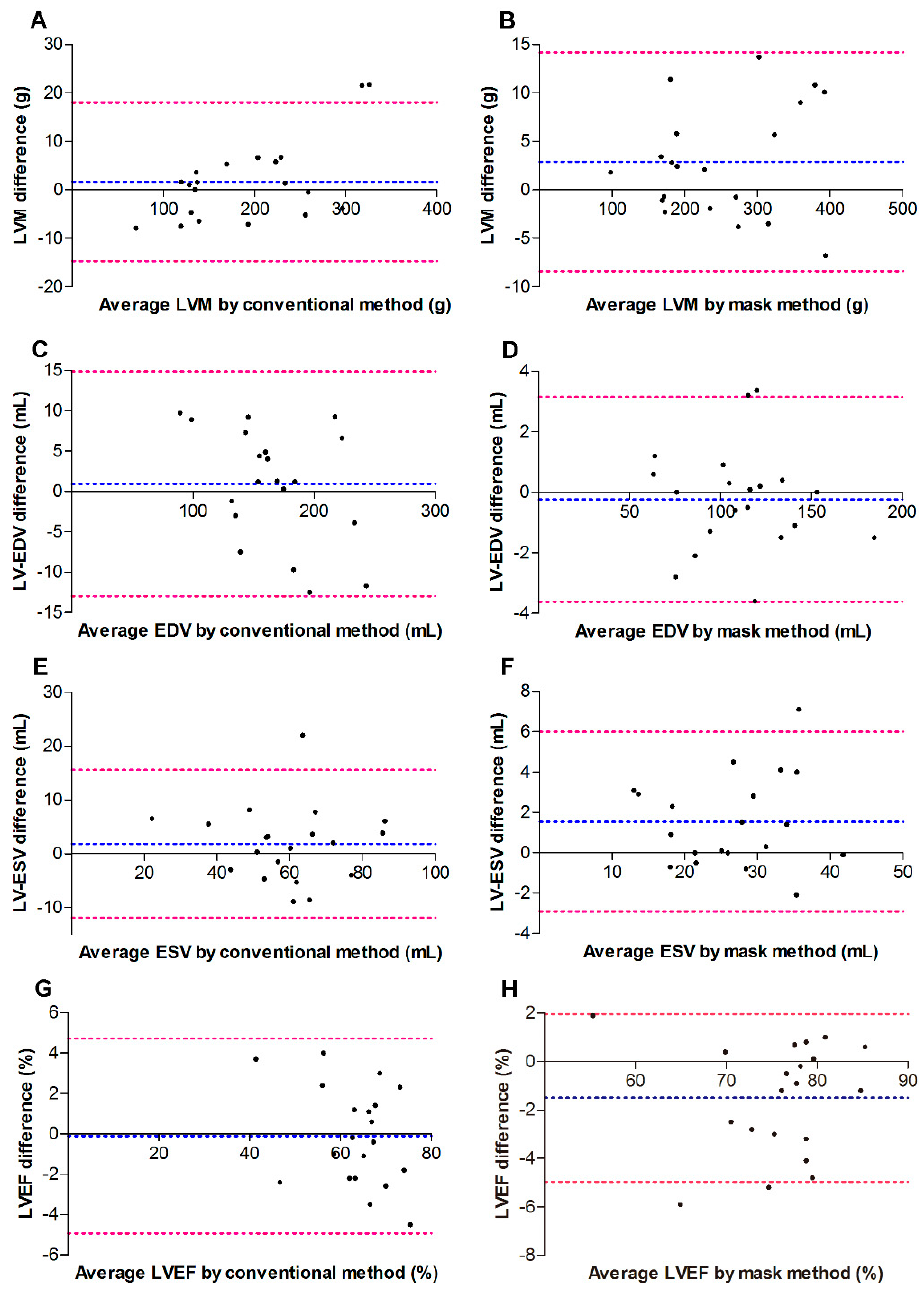
Figure 4. Bland–Altman plots indicating intra-observer agreement for 20 randomly selected subjects. ( A , C , E , G ) indicate data for the standard method. ( B , D , F , H ) indicate data for the standard method. Blue dashed line, bias; red dashed line, 95% limits of agreement between inter-obsever variability. EDV, end diastolic volume; ESV, end systolic volume; LVEF, left ventricular (LV) ejection fraction; LVM, LV mass.